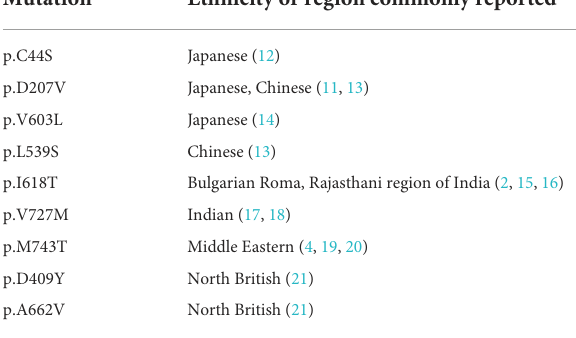
TABLE 1 Common GNE myopathy variants and associated regions.